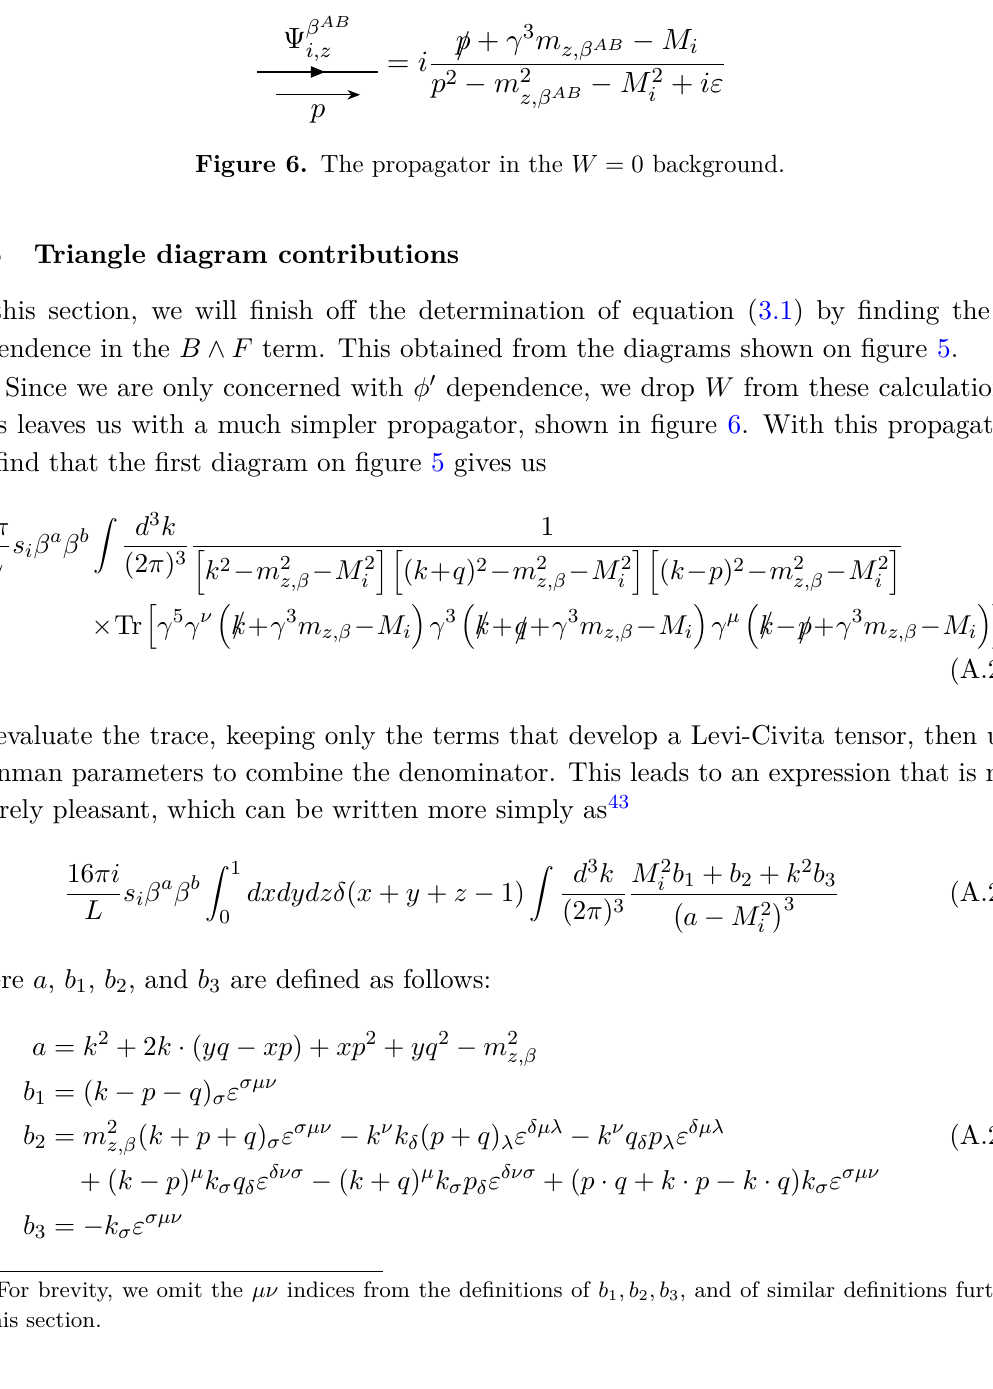
Figure 5. The triangle diagrams contributing to the B ∧ dA φ 0 term.